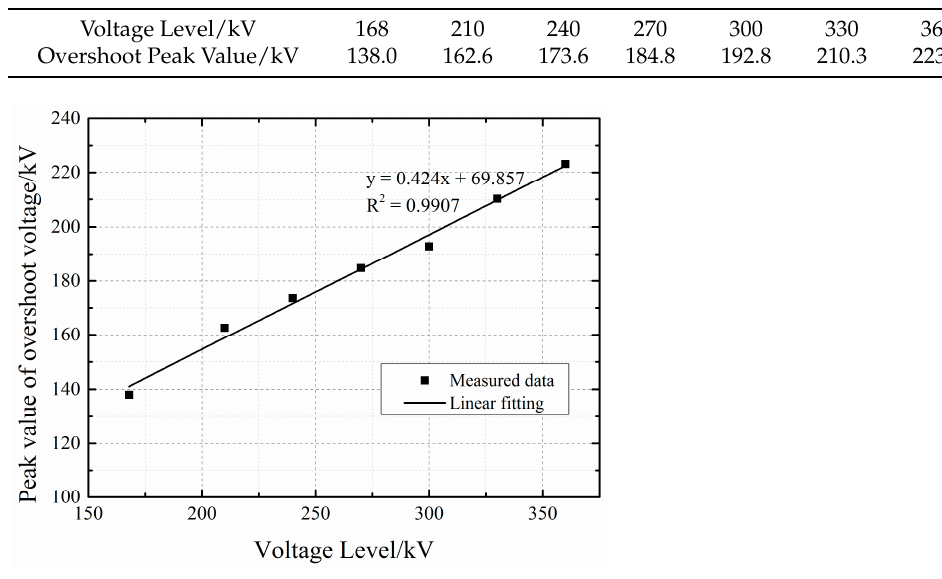
Figure 6. Peak values of overshoot voltage at different voltage levels. It can be seen from Figure 6 that the peak value of overshoot voltage is linear with the voltage level of the pulse current injection source, that is, it is linear with the pulse current. The linear fitting results are as